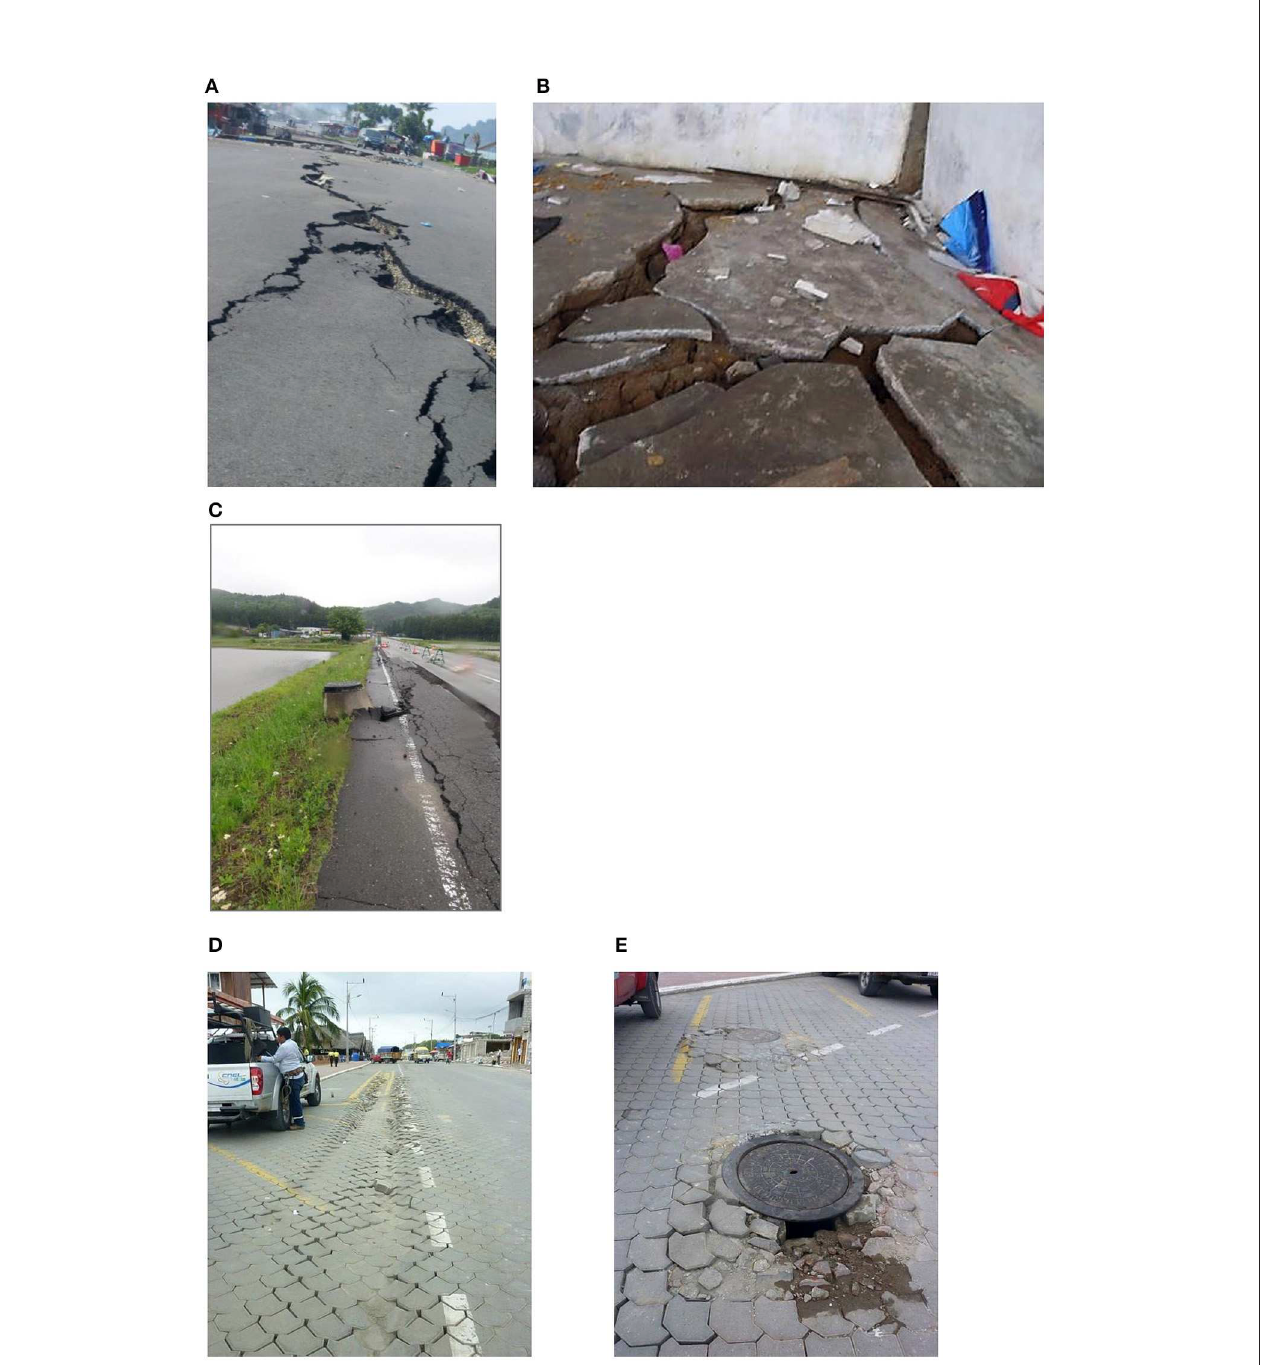
FIGURE 13 | Consequence of soil liquefaction following the Padang, Tohoku, and Muisne earthquakes. (A) Tension cracks arising from lateral spreading at Padang city. (B) upheaval of floor slabs of village house due to liquefaction at Perumdam Village, Padang. (C) Uplift of manhole and lateral spreading at Shirakawa. (D) ground settlement on pavement at Pedernales. (E) uplift of manhole close to the observe ground settlement at Pedemales.